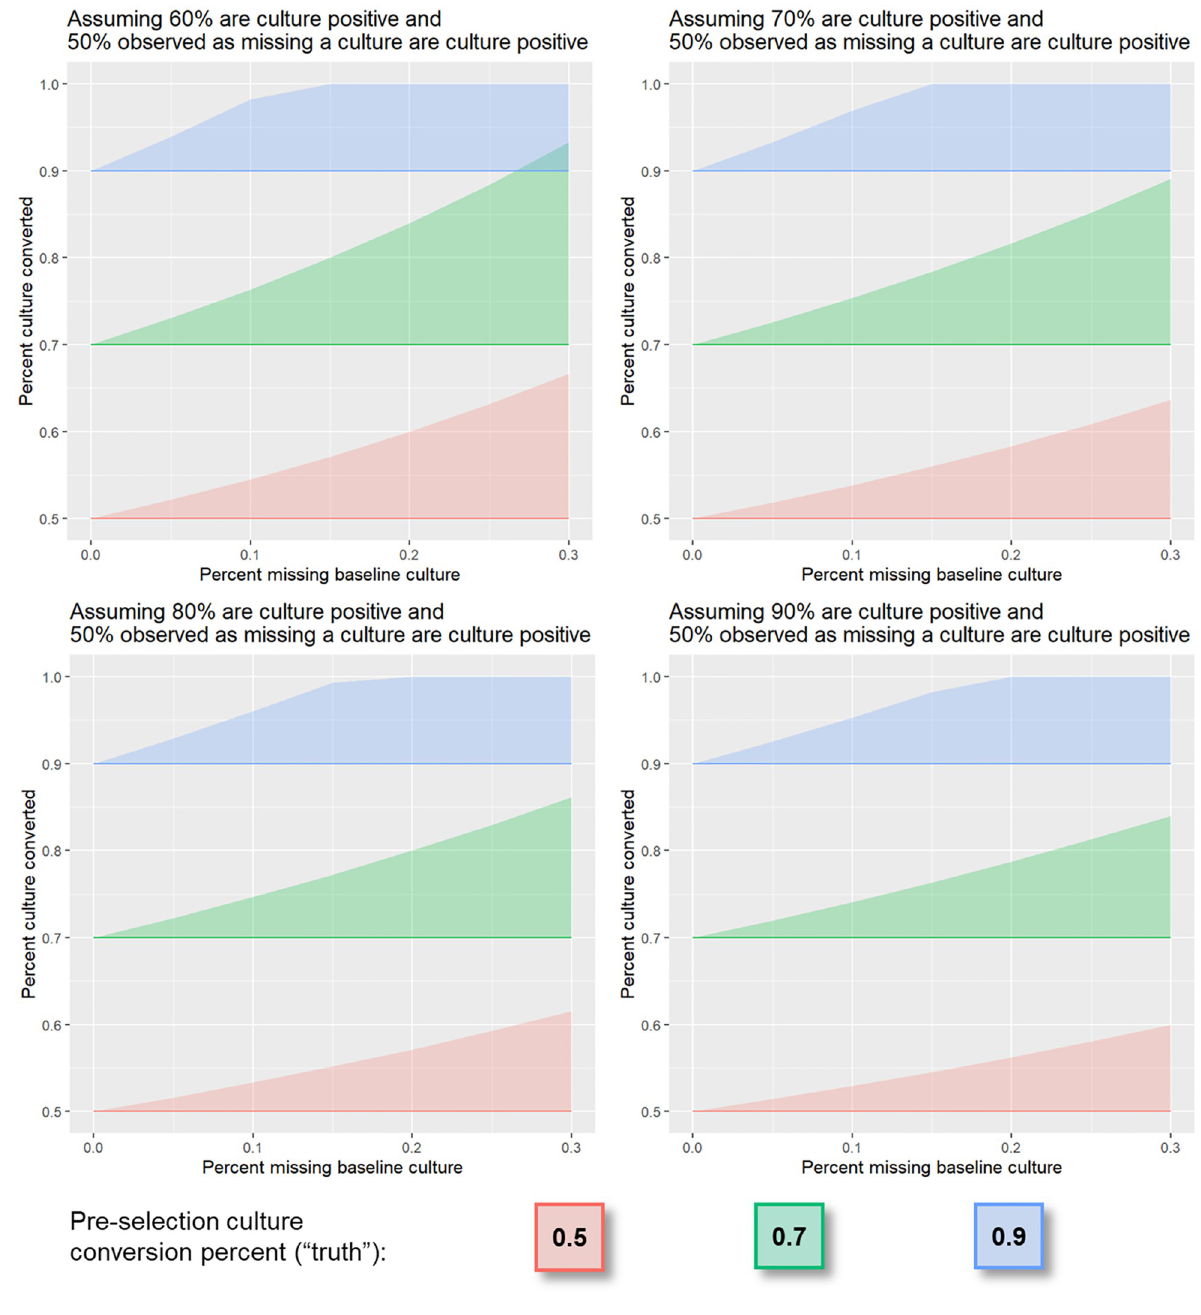
Fig 3. Culture conversion among participants missing a pre-treatment culture, simulation study of cohort where P t varies from 60% to 90%, P t │ m = 50%, and C │ P t = 50%, 70%, or 90%. As the proportion of patients culture positive at treatment initiation increases (each panel), the potential magnitude of bias decreases (shaded regions become smaller). This is because, assuming the proportion missing a culture who are culture positive is held constant (here, 50%), the exclusion of the same number of patients from a smaller cohort (i.e. smaller proportion of culture positive patients = smaller denominator) is more influential on the observed proportion with culture conversion than in a larger cohort (i.e. larger proportion of culture positive patients = larger